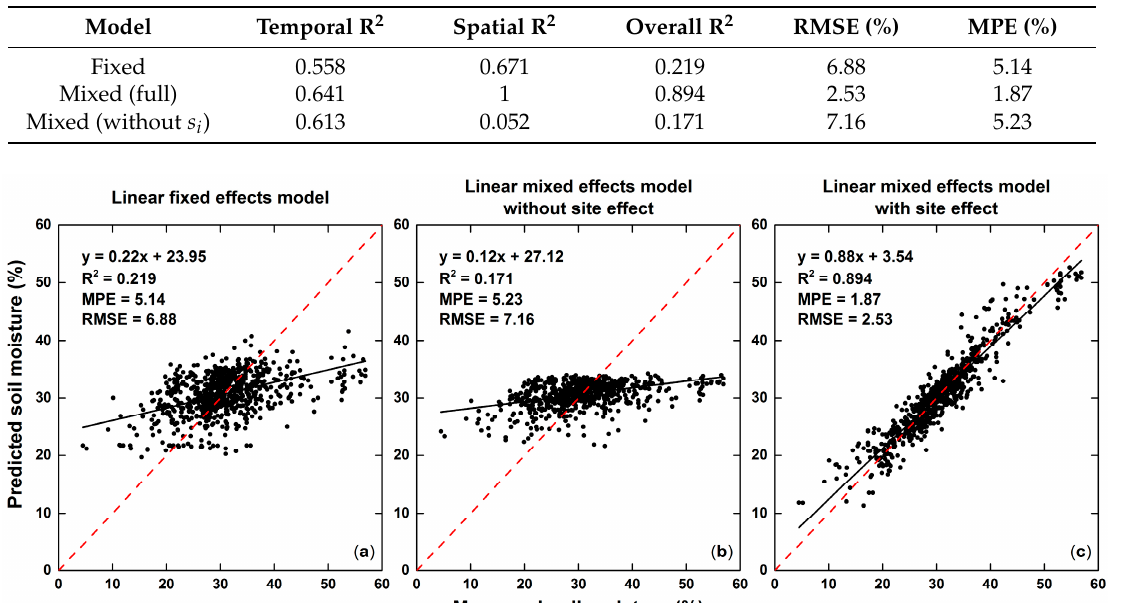
Table 4. Performance statistics for three linear fixed and mixed effects models.